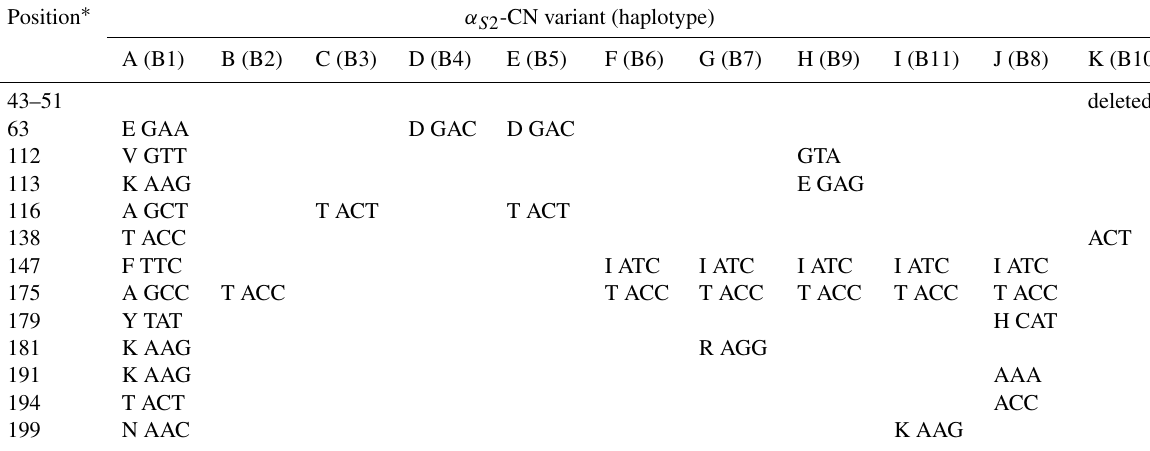
Table 4. Amino acid positions and differences in genetic variants of buffalo α S 2 -CN.